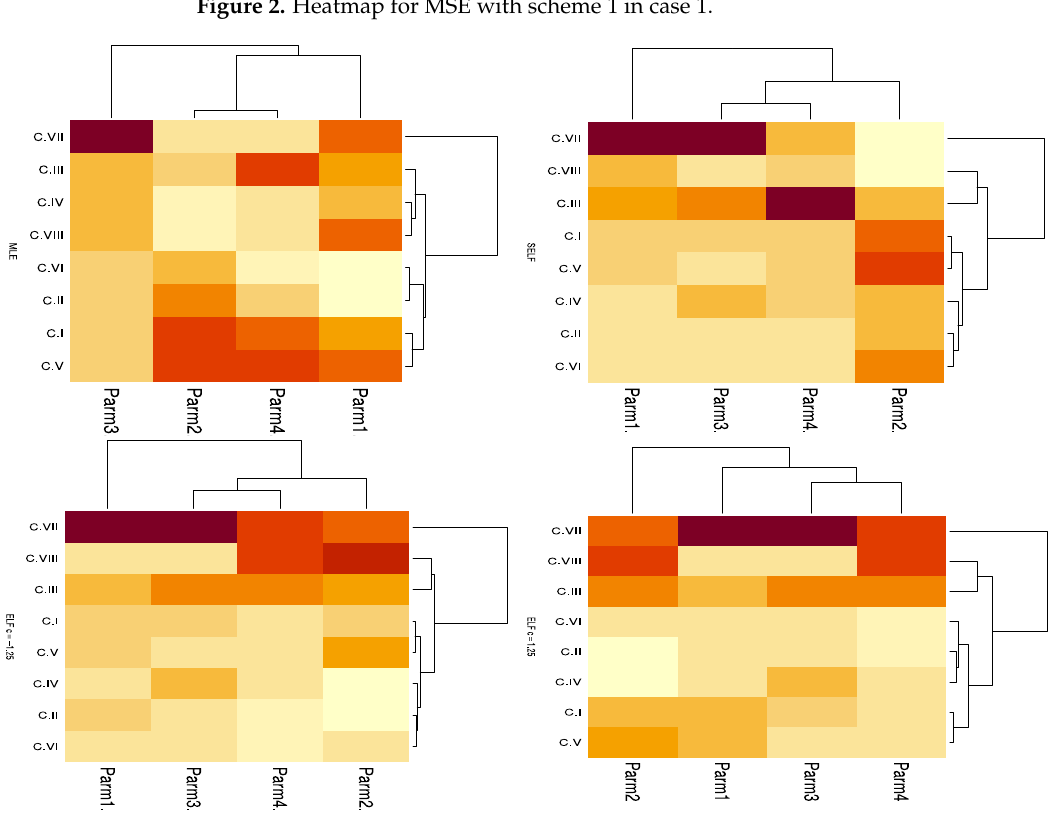
Figure 2. Heatmap for MSE with scheme 1 in case 1.